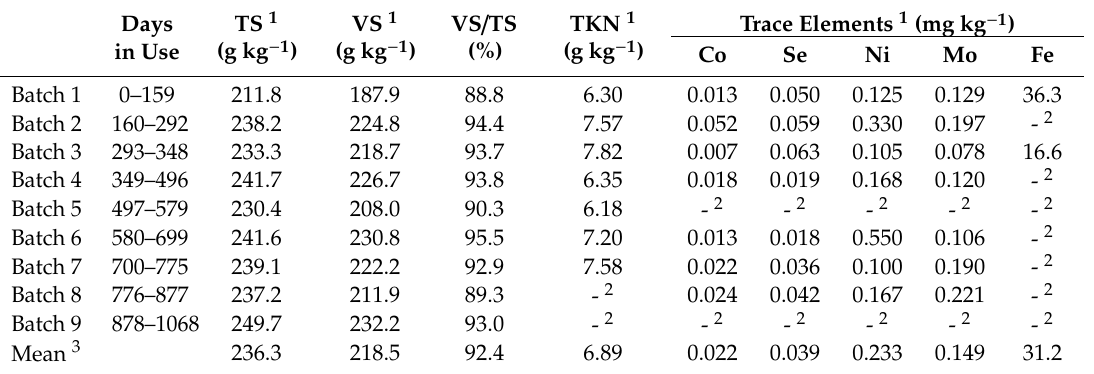
Table 1. Characteristics of food waste used in this study (after manual removal of non-biodegradable components and maceration): total solids (TS), volatile solids (VS), total Kjeldahl nitrogen (TKN), trace